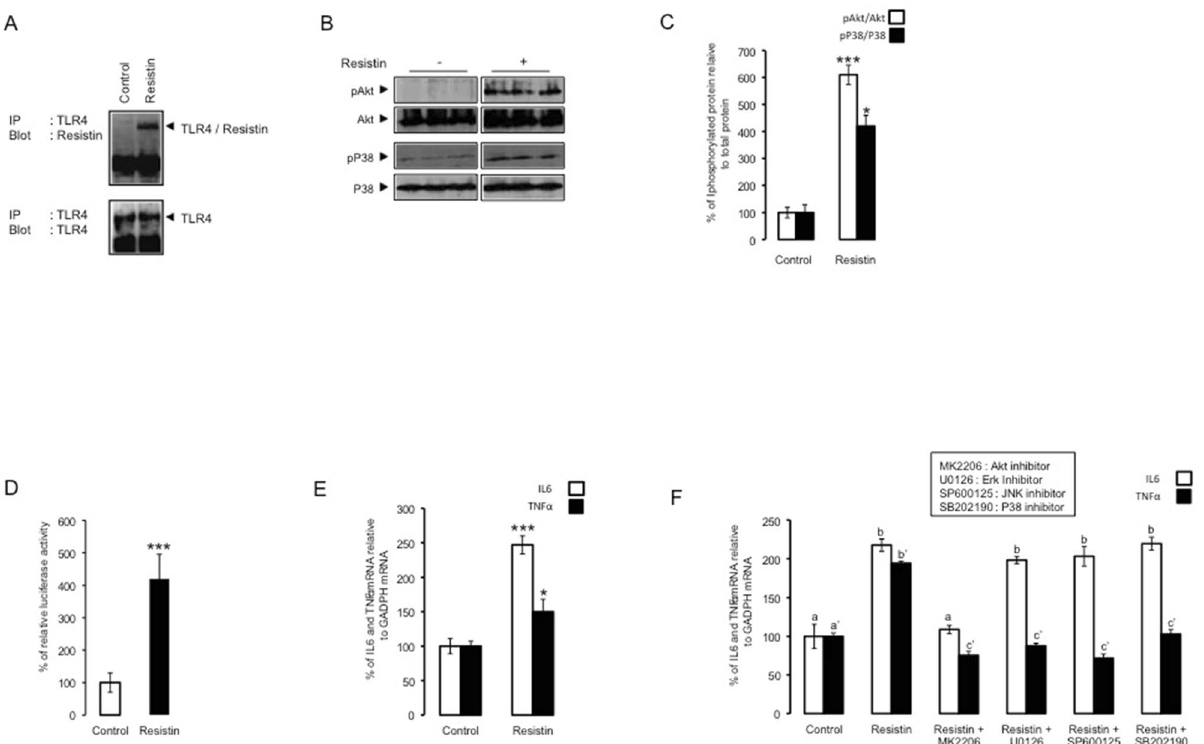
Figure 3. Resistin increased neuroinflammation through its binding to TLR4. (Panel A ) Immunoprecipitation/ Immunoblot (IP/IB) analysis of the direct association of resistin with TLR4 in protein extracts from SH-SY5Y cells treated with resistin (100 ng/ml) for 16 h in the presence or absence of the cross-linker agent BS3, the shown blots are from the same membrane but blotted with different antibodies following immunoprecipitation with anti-TLR4 antibody. (Panel B , C ) SH-SY5Y cells were treated with or without resistin and then Akt and p38 MAP kinase phosphorylation measured by Western blots using adequate antibodies and the presented blots was from the same membrane but blotted successively with different antibodies, the band densities were quantified and expressed as phosphorylated/total proteins. Data were presented as means ± SEM (n = 3), * and *** denoted significant differences vs control at p < 0.05 and p < 0.0005, respectively. (Panel D ) human SH-SY5Y neuroblastoma cells stably transfected with NF-κB luciferase reporter gene were treated resistin and relative luciferase activity determined. (Panel F ) Human SH-SY5Y neuroblastoma cells were treated with resistin in the presence or absence of Akt, Erk, JNK or p38 MAP kinase inhibitors, and then IL6 and TNFα expression was determined using specific primers for these two genes, and normalized using GAPDH. Data were presented as means ± SEM (n = 3). Columns marked by different letter differ (with or without asterix concerns TNFα or IL6, respectively) significantly (p < 0.05). For other panels, data were presented as means ± SEM (n = 3), * and *** denoted significant differences at p < 0.05 and p < 0.005, respectively. (Panel E ) Human SH-SY5Y neuroblastoma cells were treated with resistin or placebo and then IL6 and TNFα expression was determined using adequate primers, and normalized using GAPDH. Data were presented as means ± SEM (n = 3), * and *** denoted significant differences at p < 0.05 and p < 0.001, respectively.